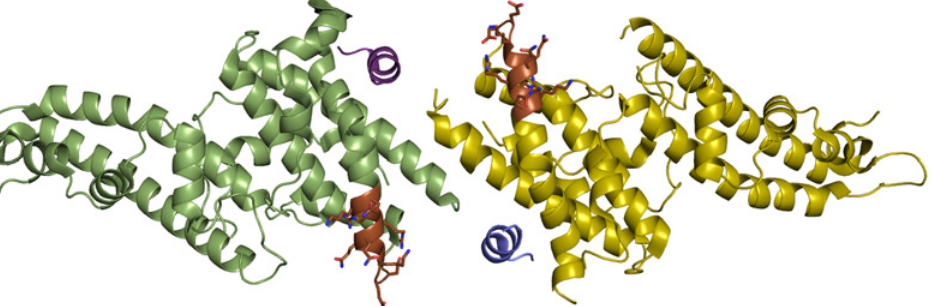
Fig 1. Location of DEK polymorphisms on Sal1 DBP-II. DEK polymorphisms (DEKAQQRRKQ) mapped onto the Sal1 DBP-II and DARC heterotetramer. DEK residues are shown in brown and side chains are displayed as sticks. The two DBP-II molecules are in green and yellow. The two DARC peptides are in purple and